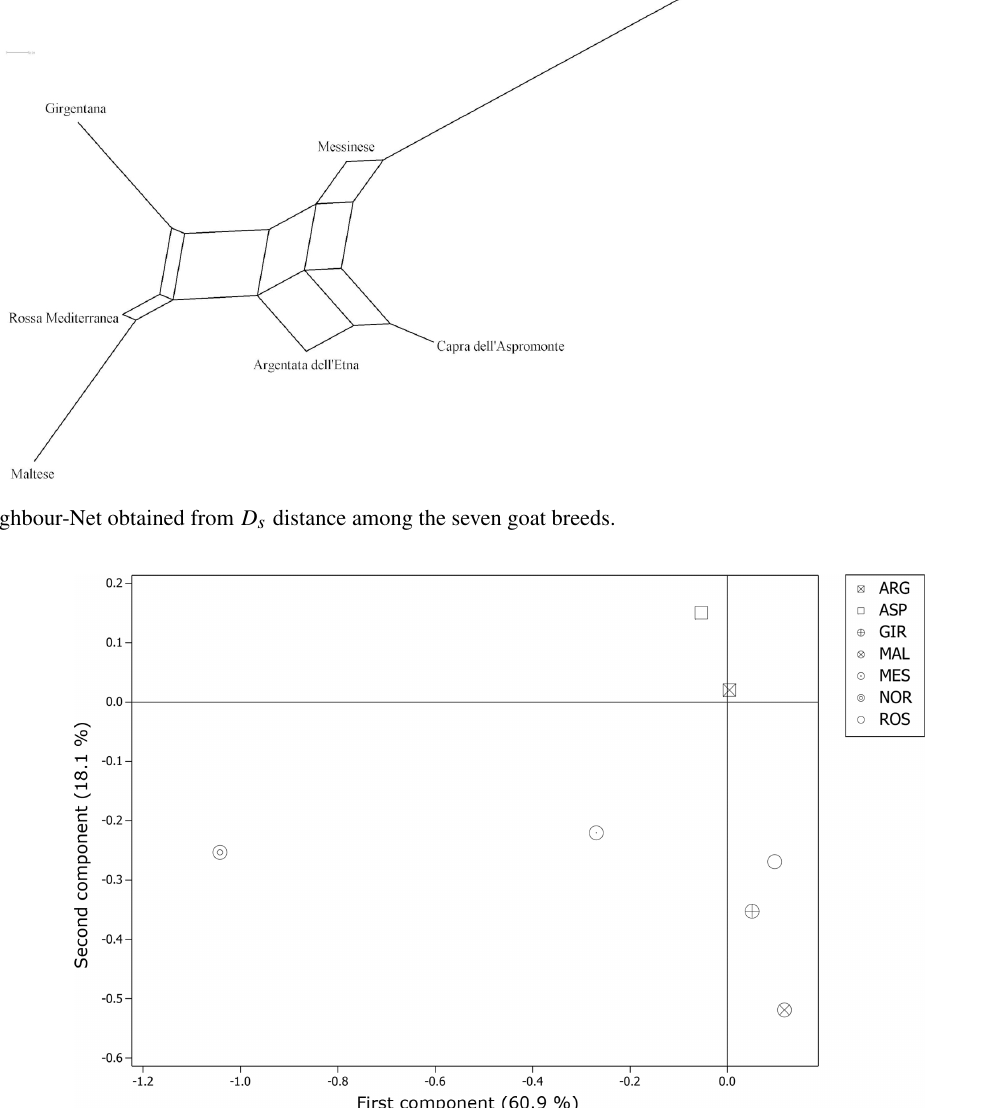
Figure 2. Score plot of the principal component analysis on inferred haplotypes among the seven goat breeds.